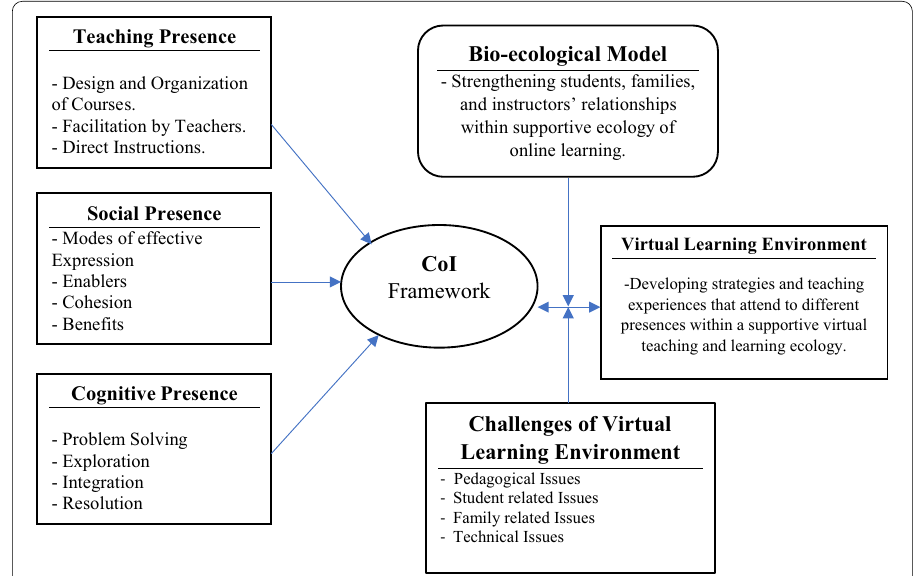
Fig. 5 Relationships among the CoI framework, bioecological model, and virtual learning